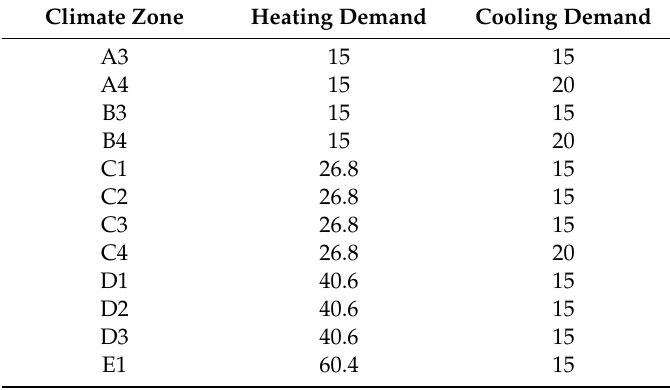
Table 1. Maximum heating and cooling demand per climate zone for legal